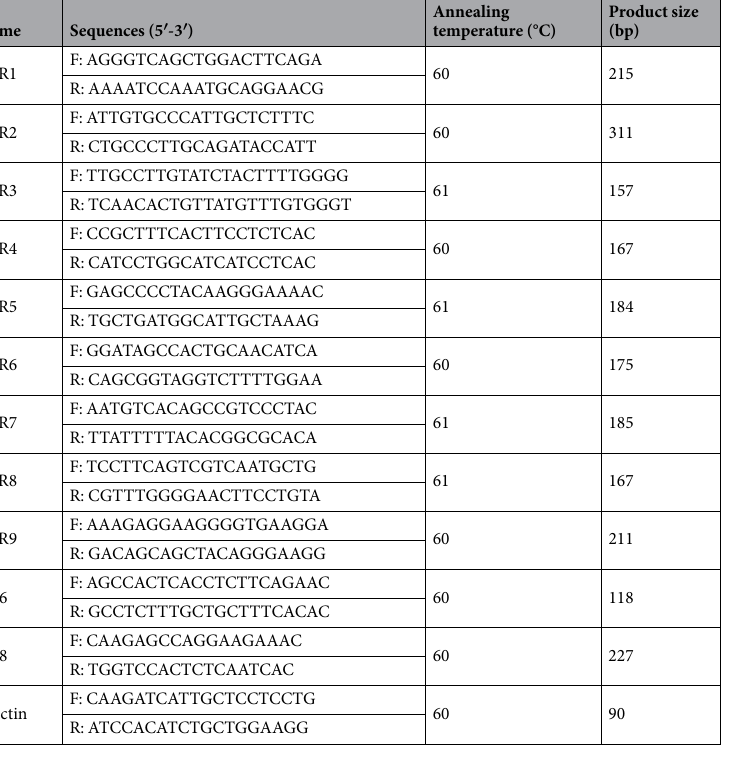
Table 1. Primers for real-time RT-PCR. Note: RT-PCR, real time-polymerase chain reaction; TLR, Toll-like receptor; IL,